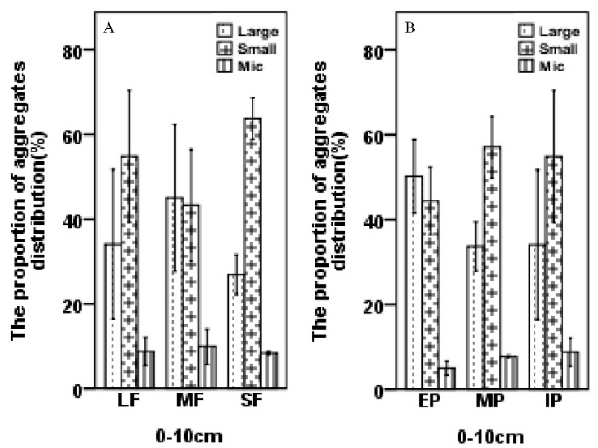
Figure 1. The proportion of all soil aggregates accounted for by three type of soil aggregates among different type of plots: ( A ) proportion of three types of aggregates among different forest fragments with different patch sizes; ( B ) proportion of three types of aggregates from forest edges to interiors. LF: large forest; MF: medium forest; SF: small forest; EP: edge plots; MP: middle plots; IP: interior plots.